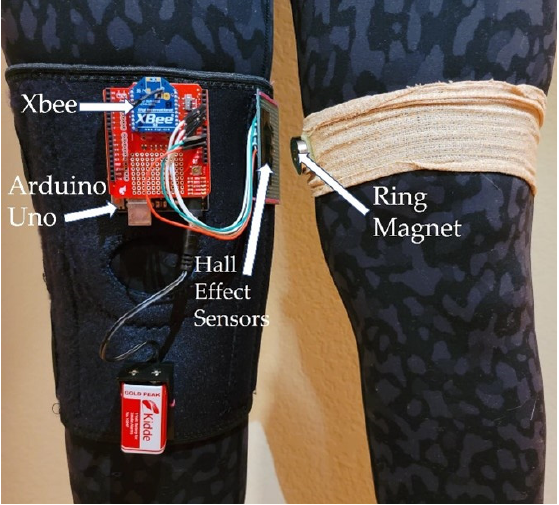
Figure 2. Prototype of Wearable Gait Monitoring System.